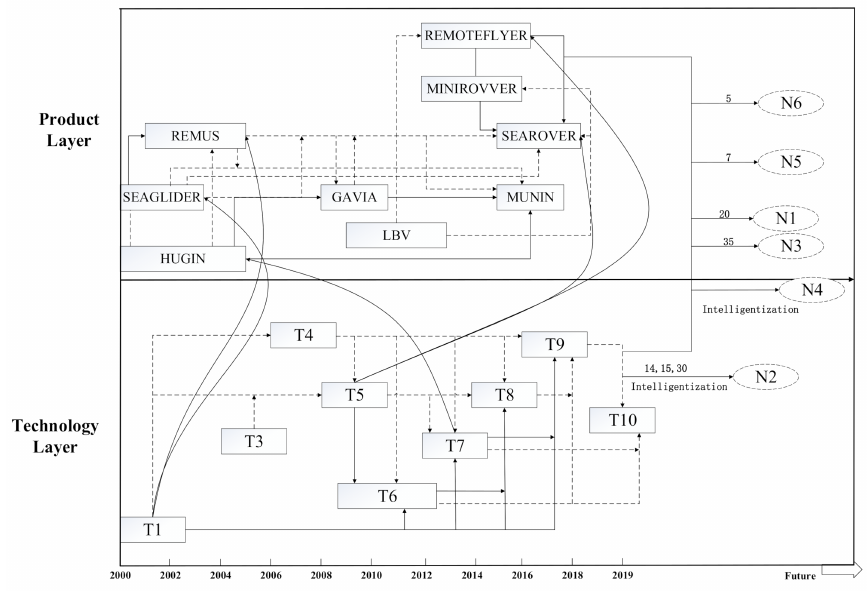
Figure 6. The MA-based TRM of underwater vehicles for new